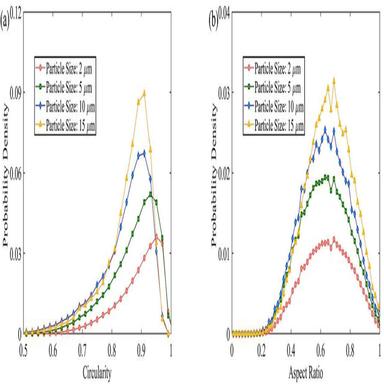
Correlated volume-weighted probability density at different particle sizes for the coarse (220F) powder after dynamic deformation: (a) probability density of circularity, and (b) probability density of aspect ratio.